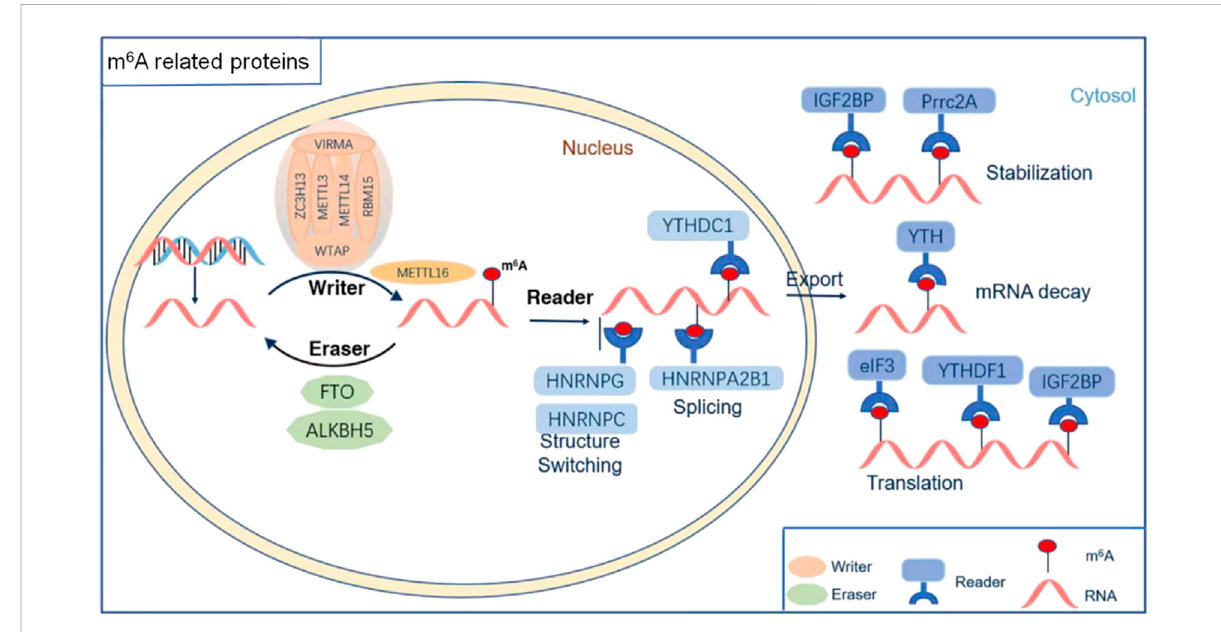
FIGURE 1 The molecular mechanism of RNA m 6 A modi fi cation. m 6 A methylation was catalyzed by the writer complex, including METTL3, METTL14, METTL16, WTAP, KIAA1429, RBM15/15B, and ZC3H13. The m 6 A modi fi cation was erased by demethylases, including FTO and ALKBH5. The m 6 A-modi fi ed RNA reader proteins included YTHDF1/2/3, YTHDC1/2, IGF2BP1/2/3, HNRNPC/G, HNRNPA2B1, Prrc2A, and